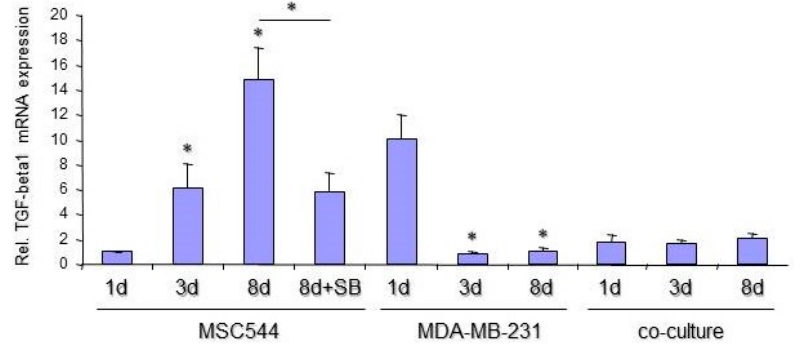
Figure 6. Quantification of TGF- β 1-specific mRNA in MSC544 and MDA-MB-231 mono-cultures, and in MSC544 / MDA-MB-231 co-cultures. Following culture for the indicated times and stimulation for eight days (8 d) with 5 µ M SB431542 (SB, only MSC544), the cells were lysed and subjected to RNA isolation and quantitative PCR (qPCR) analyses of TGF- β 1. Data were normalized to three housekeeping genes ( β -actin, GAPDH, and TBP) amplified from the same sample and are the mean + s.d. from a representative experiment. The asterisks indicate significance relative to the respective 1 d culture ( p < 0.05, unpaired two-tailed student’s t -test).